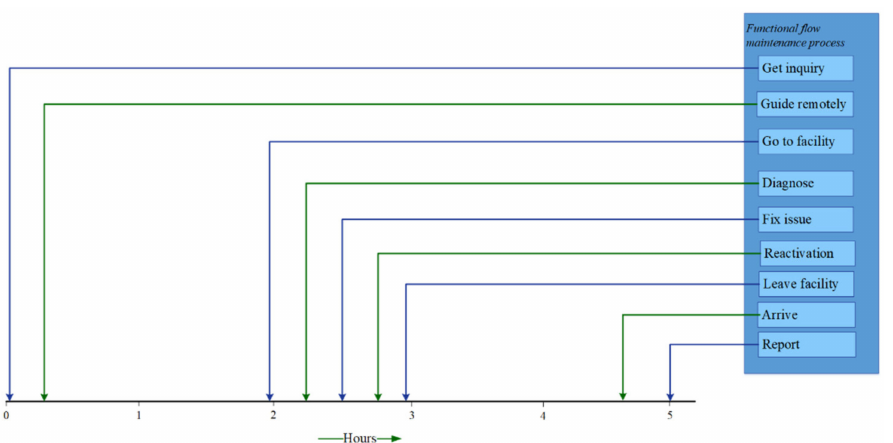
Figure 25. Functional flow for the maintenance process in the company, focusing on the gate as a use case.